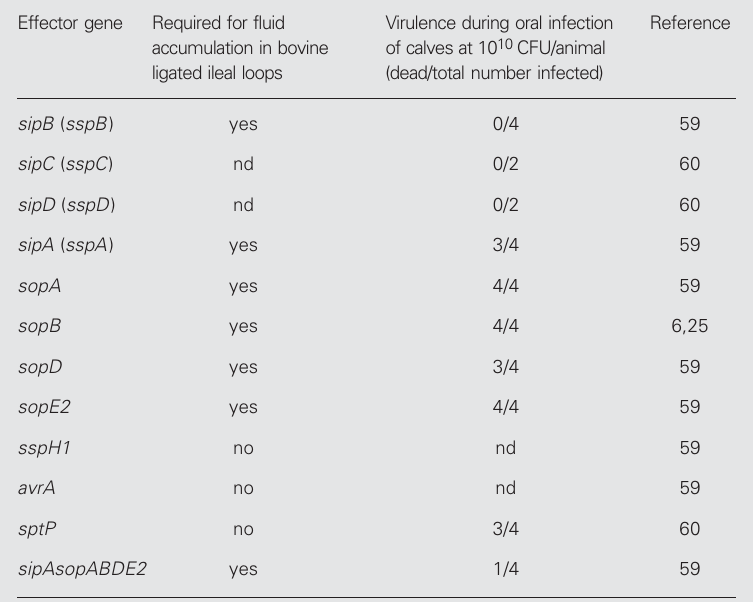
Table 1. Role of virulence genes in enteropathogenesis. Effector gene Required for fluid Virulence during oral infection